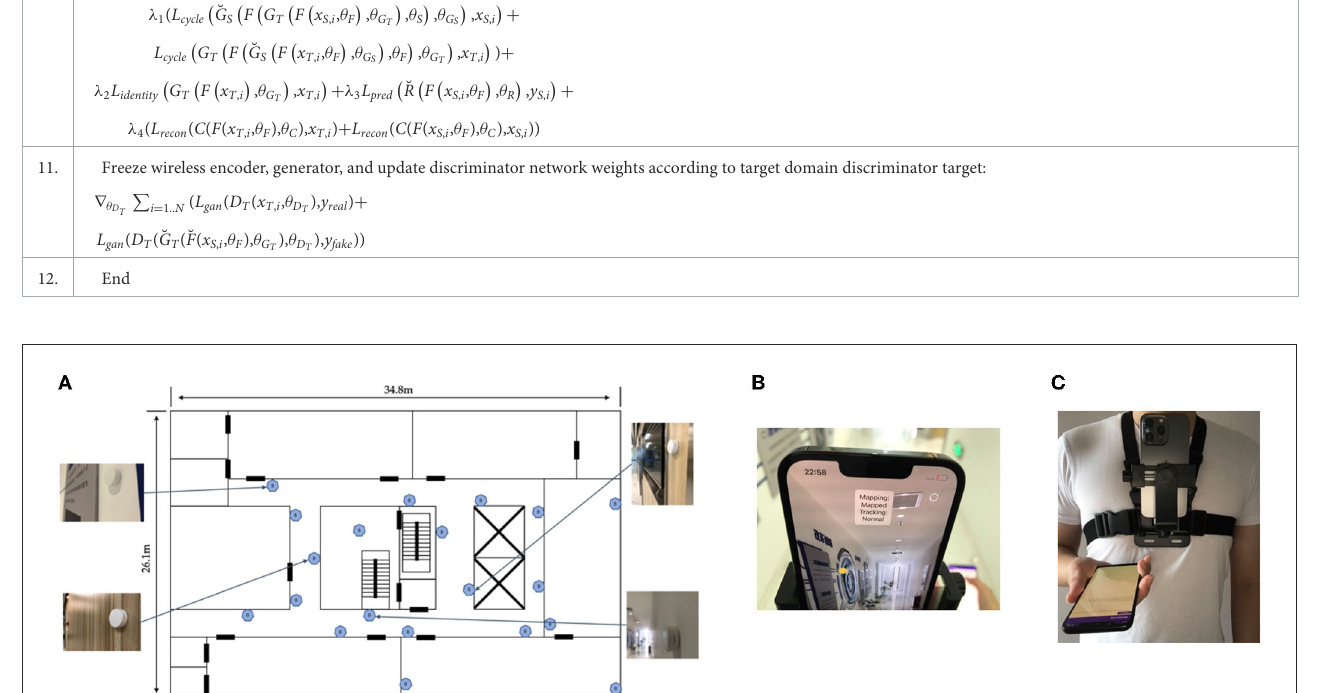
FIGURE6 (A) Experiment testbed. (B) Lidar slam on iPhone. (C) Device setup on body.